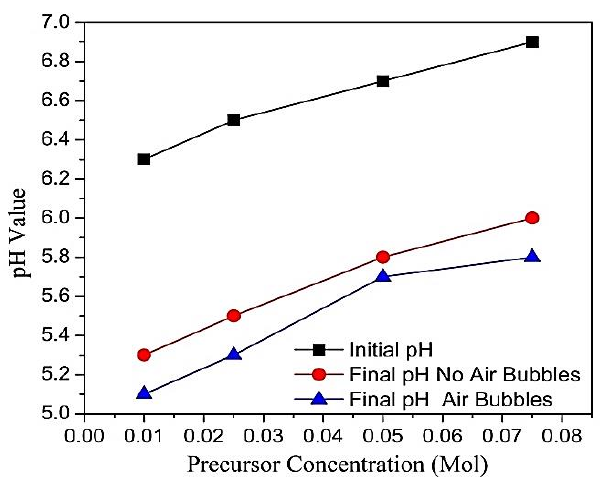
Figure 4. Effect of precursor concentration on the initial and final growth solution pH values for ZnO nanorods synthesized in the presence and absence of air bubbles.